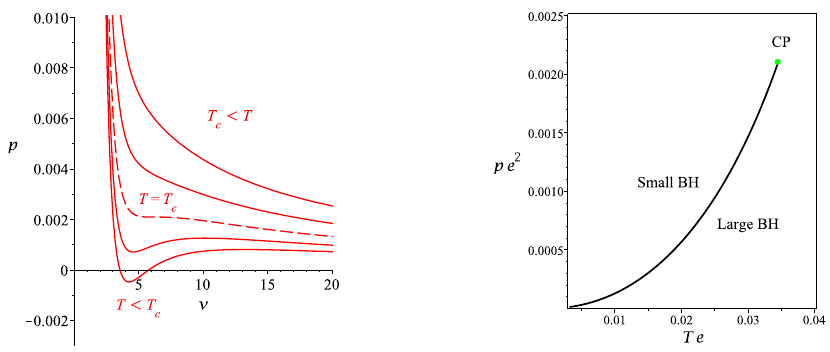
Figure 4 . Van der Waals phase transition in four dimensions (colour online). Left : the graph of pressure versus volume at various (cid:12)xed temperatures for d = 4 and k = 1 shows the occurrence of a (cid:12)rst order phase transition with VdW behaviour. The dashed line has T = T c , the solid red lines with T < T c are T = 0 : 8 T c and 0 : 65 T c , and the solid red lines with T > T c are T = 1 : 3 T c ; 1 : 7 T c . Right : the coexistence line in the pressure/temperature plane. In both graphs e = 1, (cid:12) 3 = (cid:0) 4 e 4 and (cid:11) 4 = 5 e 6 with T c e (cid:25) 0 : 03448; similar behaviour happens for any other values chosen from the physical domain given in (cid:12)gure 3. Appropriate factors of the electric charge parameter e are employed to make the relevant quantities